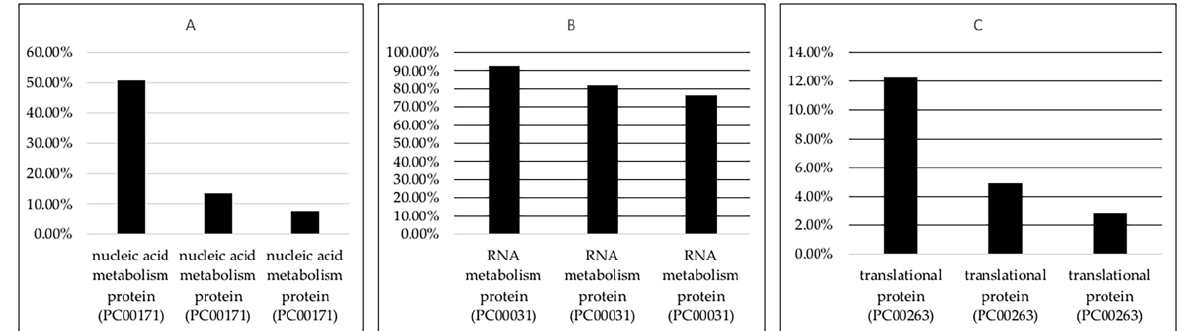
Figure 3. Bar diagram showing the protein classes nucleic acid metabolism (PC00171) ( A ), RNA metabolism ( B ) and translational proteins ( C ) of the targets of decreased lncRNA, increased lncRNA and the proteins coded by the human genome (from left to right). Representative protein classes are shown in the bottom. Increased proportion of the proteins among the targets of lncRNA was statistically significant ( p < 0.05).